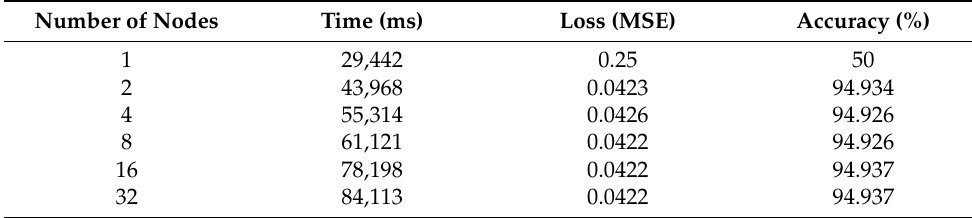
Table 6. Performance table of the evaluation model according to the number of nodes.